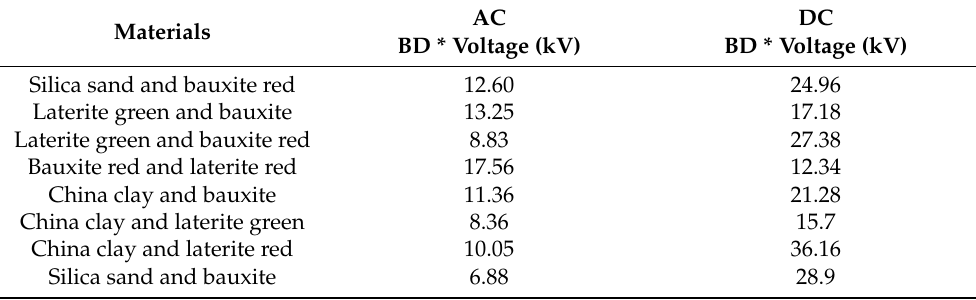
Table 6. Breakdown voltages of samples mixed